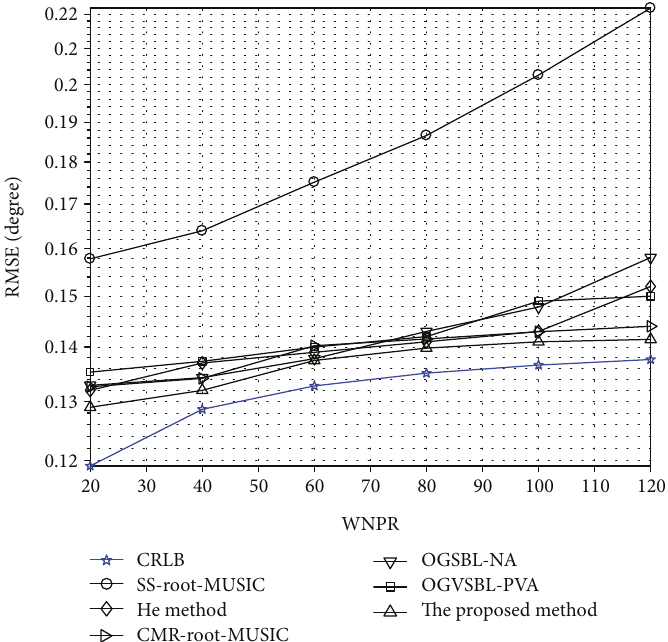
Figure 8: RMSEs of DoA estimation versus WNPR for M = 6 , N = 500 , and SNR = 0 dB